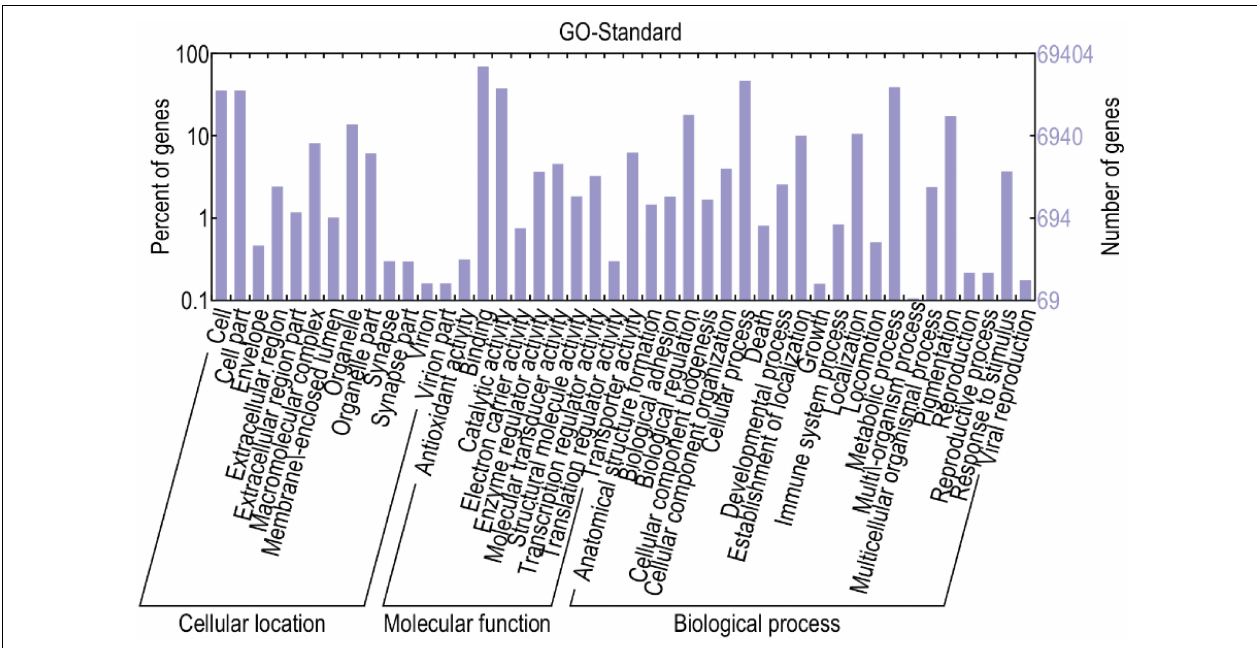
FIGURE 5 | GO analysis of differential genes. This figure, clustering analysis was performed on the differentially expressed genes of the implant group and the control group in different periods. The results are summarized in three main categories: biological process, cellular component, and molecular function. The X -axis indicates the second level term of gene ontology; The Y -axis shows the number of genes.